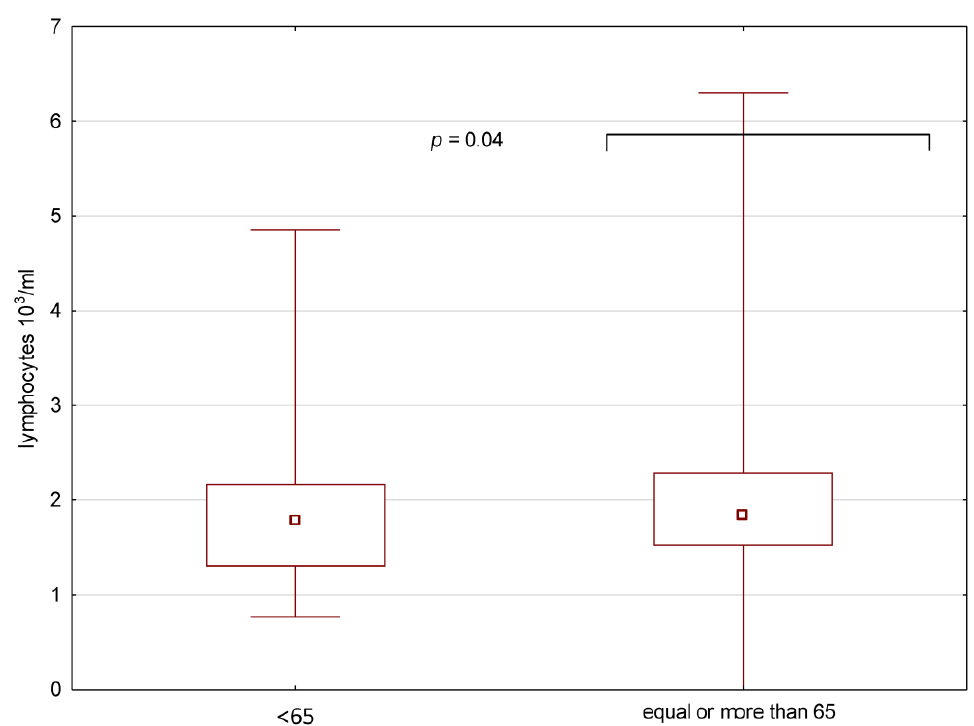
Figure 3. Lymphocytes in the peripheral blood in the two groups of patients (≥65 and <65 years of age). Table 1. Assessment median and IQR of neutrophils, lymphocytes and NRL in various phenotypes in the groups ≥ and <65 years of